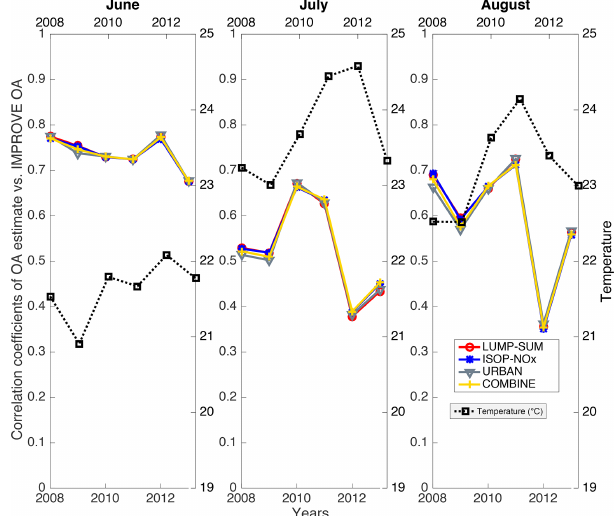
Figure 7. The correlation coefficients of the linear regression be- tween the OA estimate from four cases (red, blue, grey, and yellow) vs. EPA-corrected OA from 2008 to 2013 for June, July, and Au- gust. The monthly average ambient temperature is in